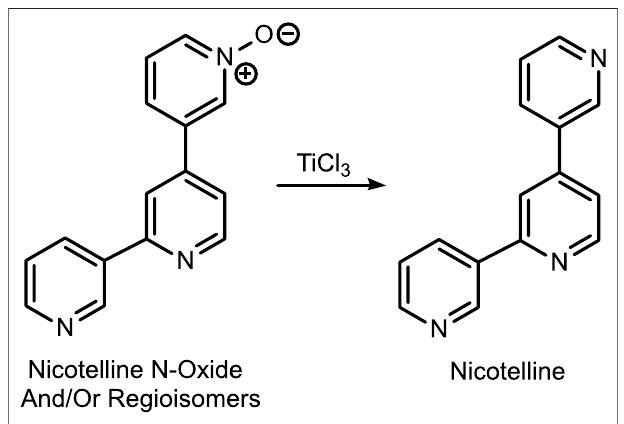
FIGURE 3 | Reduction of nicotelline N-oxides prior to LC-MS/MS analysis.